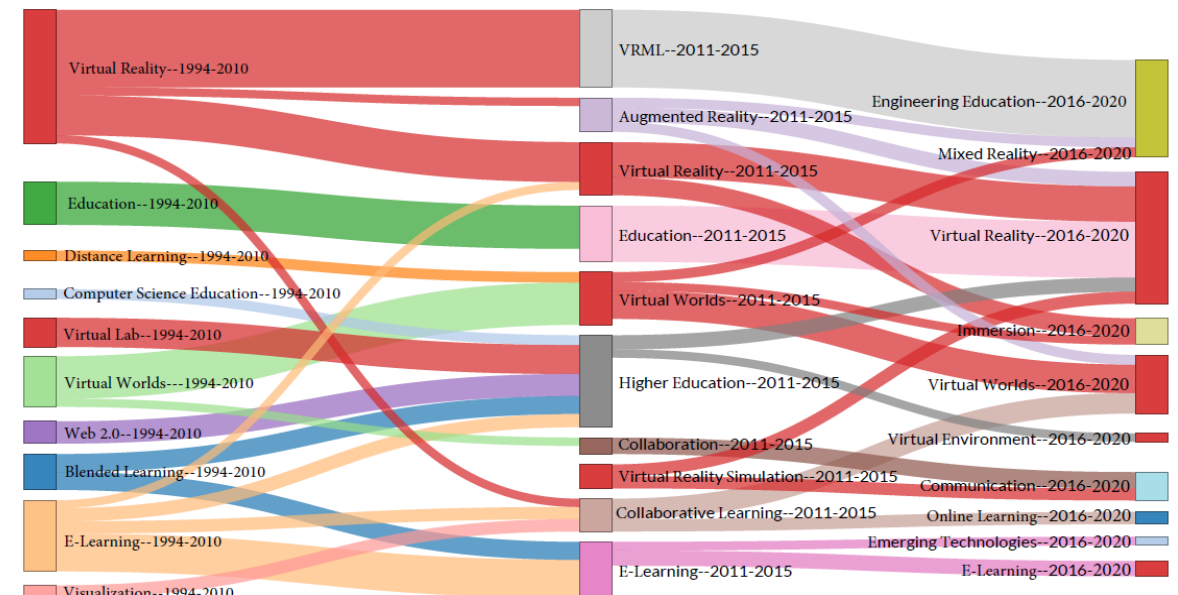
Figure 7. Thematic evolution of the author keywords.